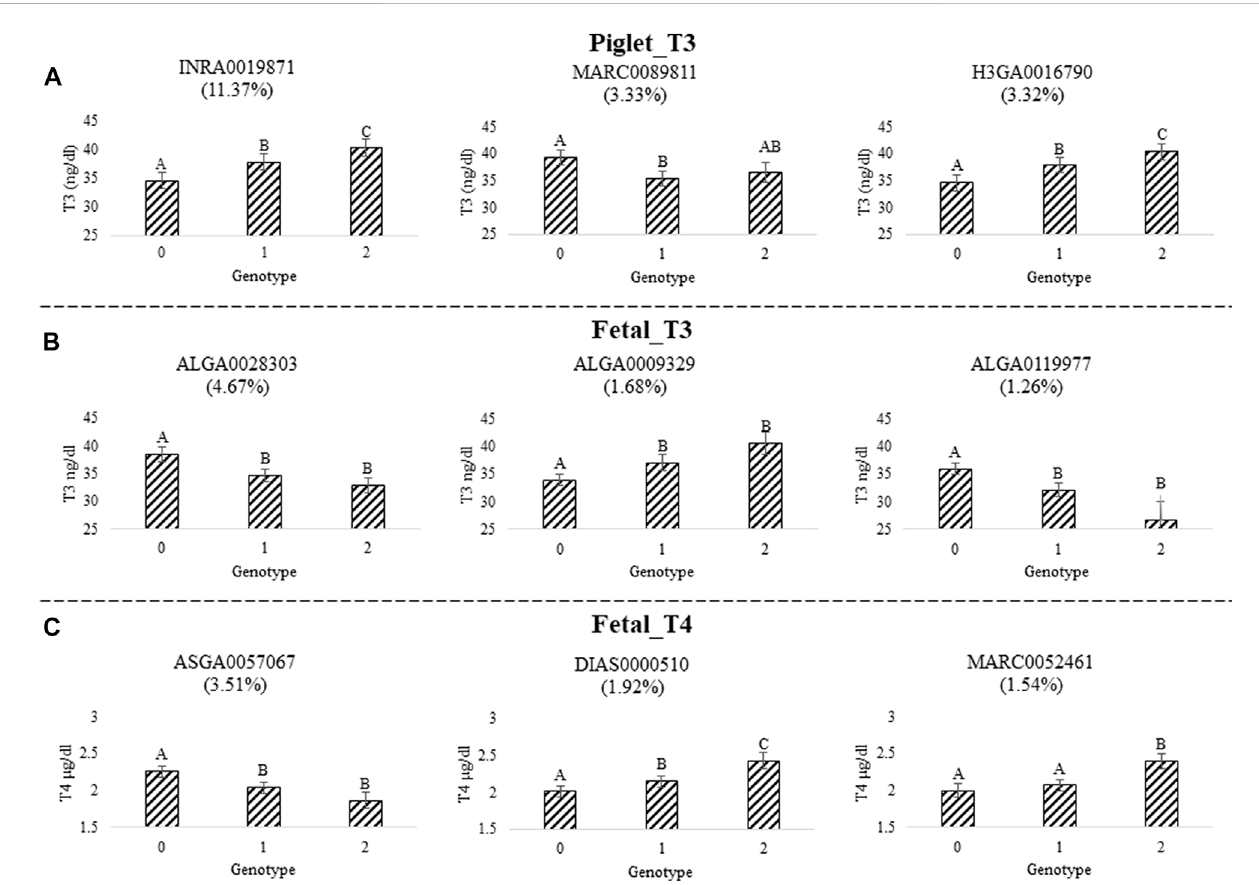
FIGURE 2 Top three SNP effects for serum thyroid hormone levels measured during challenge with PRRSV2. (A) Triiodothyronine (T3) levels were measured in piglet serum at 11DPI (piglet_T3). SNP INRA0019871, MARC0089811, and H3GA0016790 were inwindows that explained 11.37%, 3.33%, and 3.32% of the GV, respectively. (B) T3 levels were measured in fetal serum at 12 or 21 DPMI (fetal_T3). SNP ALGA0028303, ALGA0009329, and ALGA0119977 were in windows that explained 4.67%, 1.68%, and 1.26% of the GV, respectively. (C) Thyroxine (T4) levels were measured in fetal serum at 12 or 21 DPMI (fetal_T4). SNP ASGA0057067, DIAS0000510, and MARC0052461 were in windows that explained 3.51%, 1.92%, and 1.54% of the GV, respectively. The results show the top 3 windows for each trait represented by the top SNP. Plots depict the LS mean ± SE of thyroid hormone levels by SNP genotype. Different letters indicate p < 0.05 after multiple testing correction. The top SNP was determined based on the SNP with the highest PPI within each of the top three 1-Mb windows that explained the largest amount of